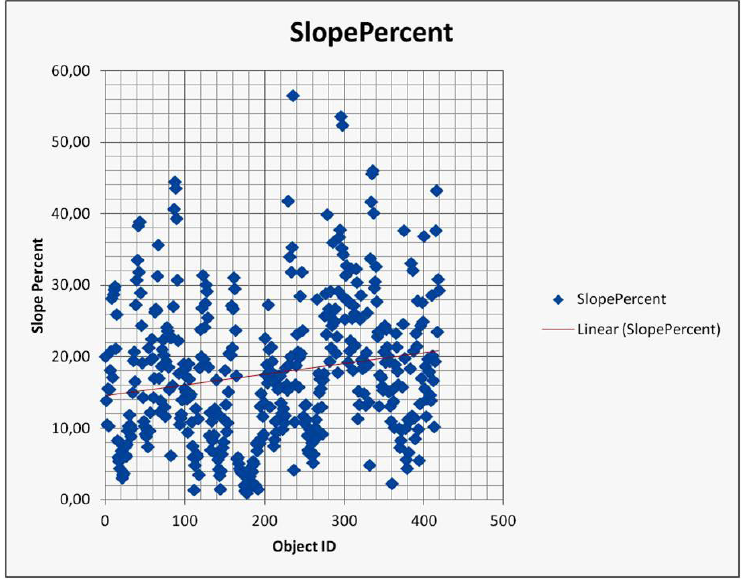
Figure 9. Correlation of percent slopes with the roads illustrated in Steffen’s map of Mycenae (Steffen, et al., 1884, map 2).